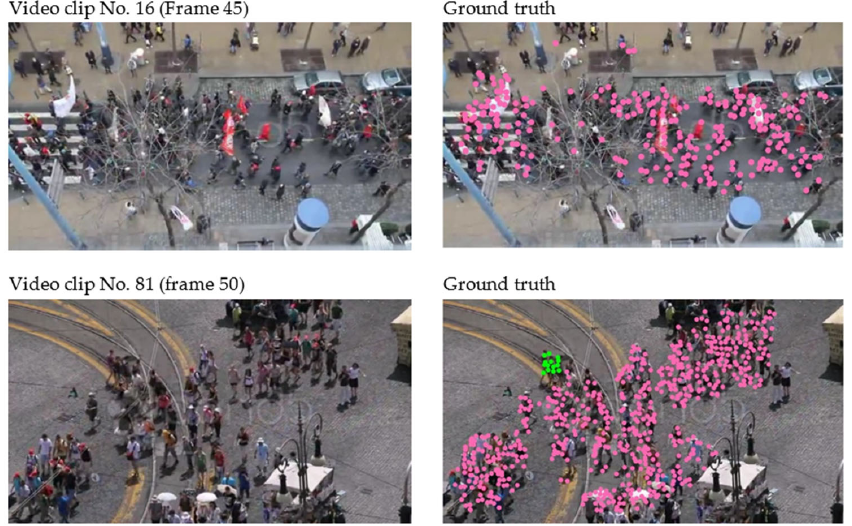
Figure 5. Examples from CUHK crowd dataset [67] with its KLT keypoints ground truth. Colored KLT points represent coherent moving clusters.